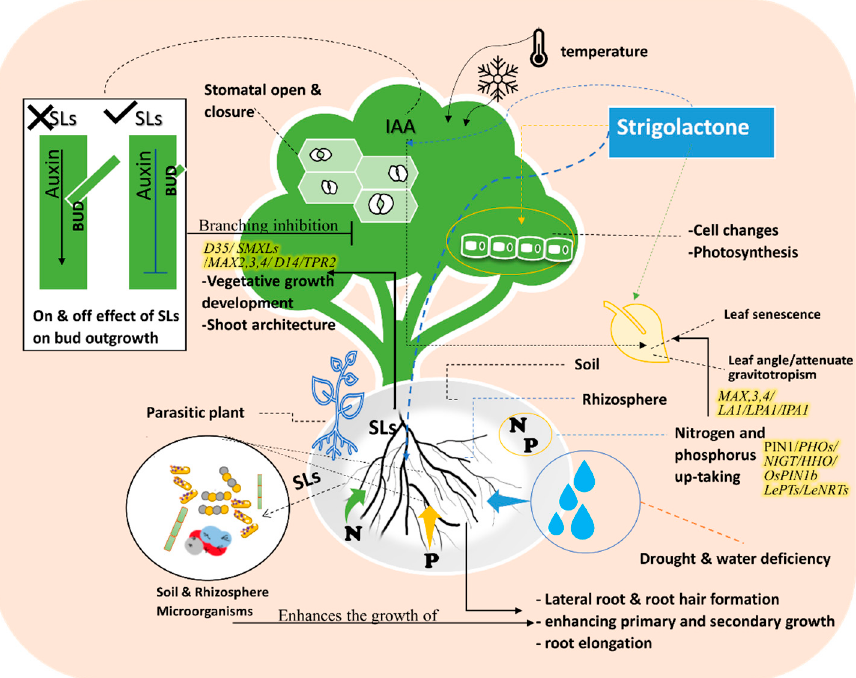
Figure 2. Effects of Strigolactone analogs (e.g., GR24) on the plant’s vegetative growth and signaling pathway under abiotic stress in relation to plant biological characteristics and soil & rhizosphere microbiome. The figure shows the role of SLs on nitrogen and phosphorus uptake. Root and Shoot architecture changes identify the effects of SLs in modifying the plant structure to cope with the abiotic stress. The figure demonstrates that SLs impact shoot branching. The plant utilizes SLs to preform mechanisms that defend itself against different abiotic stresses such as drought, senescence, temperature, light, and nutrient deficiency.